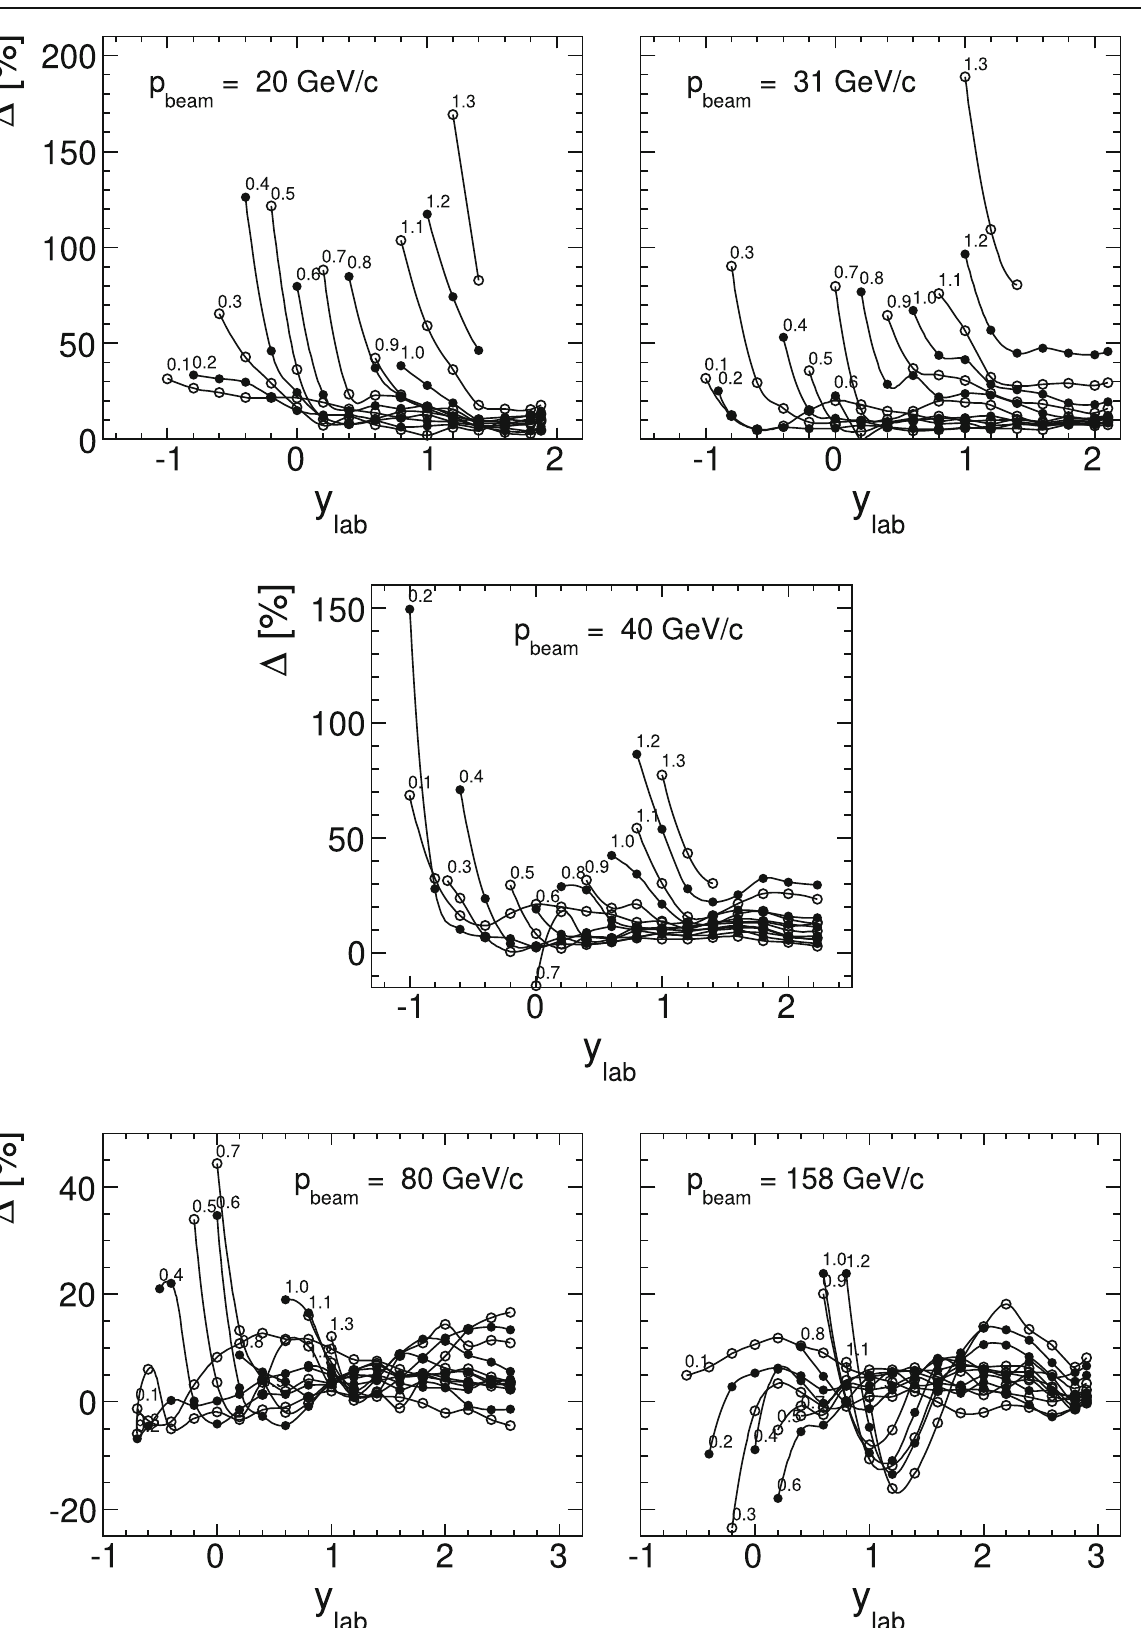
Fig. 63 Percent differences between NA61 data and the global interpolation as a function of y lab for fixed p T at all beam